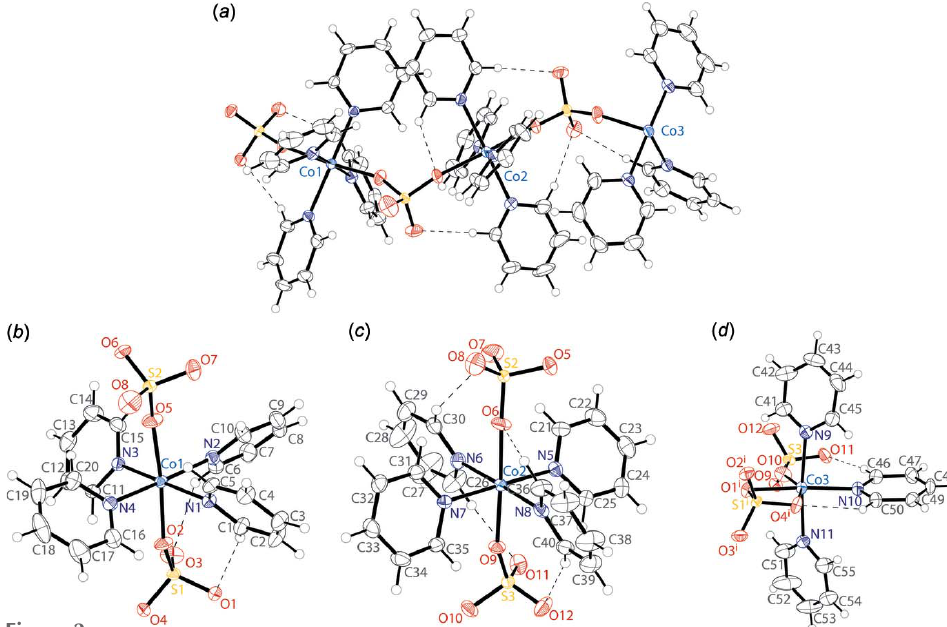
Figure 2 The molecular structure of compound ( 2 ), including ( a ) the asymmetric unit, ( b ) the coordination environment of Co1, ( c ) the coordination environment of Co2 and ( d ) the coordination environment of Co3. Displacement ellipsoids are drawn at the 50% probability level. H atoms are drawn as spheres of arbitrary radius. C—H (cid:3)(cid:3)(cid:3) O interactions (Table 2) are shown as dashed lines. [Symmetry codes: (i) 1